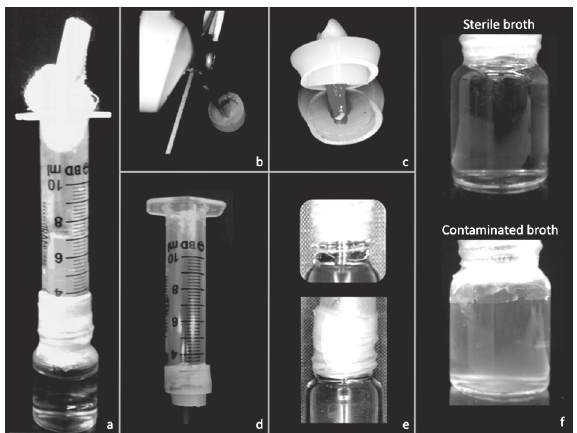
Figure 2- The apparatus used to evaluate coronal leakage (a). By using a shear, a hole was made at the center of the rubber stopper (b), through which the tooth was inserted (c). A cylinder prepared from a 10 mL plastic syringe was adapted to the outer surface of the stopper to create a chamber around the crown of the tooth (d). The glass flask filled with BHI broth was connected to the syringe/stopper/tooth set (e). Turbidity in the BHI broth was evaluated